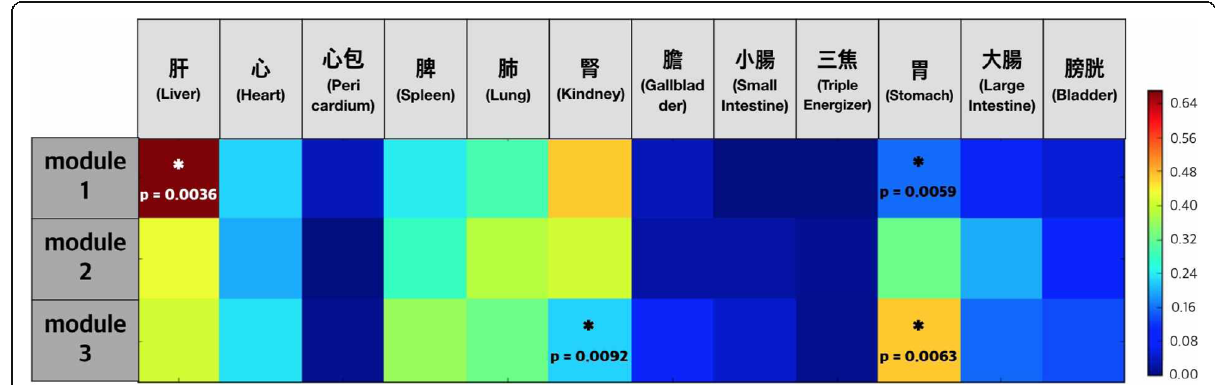
Fig. 3 Occurrence ratio of associated meridians of herbs within each